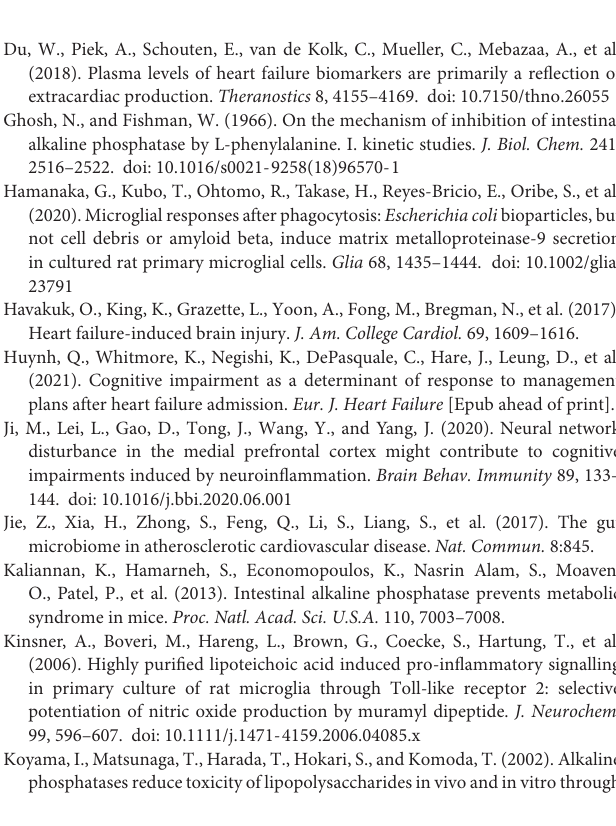
Supplementary Figure 1 | Alterations in gut sympathetic activity, fibrosis and inflammation of mice. (a) Representative images of anti-TH immunofluorescent staining (magnification, 400 × ) and Masson staining (magnification, 400 × ) in the intestinal tissues of mice. (b) The levels of plasma NE in mice. (c) Quantitative analysis of anti-TH fluorescent signals in the intestine of mice. (d) CVF of the intestinal tissues of mice. (e) CD3 gene expression in the intestinal tissues of mice. (f) CD68 gene expression in the intestinal tissues of mice. (g) TLR2 gene expression in the intestinal tissues of mice. (h) RAGE gene expression in the intestinal tissues of mice. ∗ P < 0.05 vs. the control group; # P < 0.05 vs. the HF group. TH, tyrosine hydroxylase; NE, norepinephrine; CVF, collagen volume fraction; TLR2, toll-like receptor 2; RAGE, receptor for advanced glycation end-products. Supplementary Table 1 | Sequences of specific primer